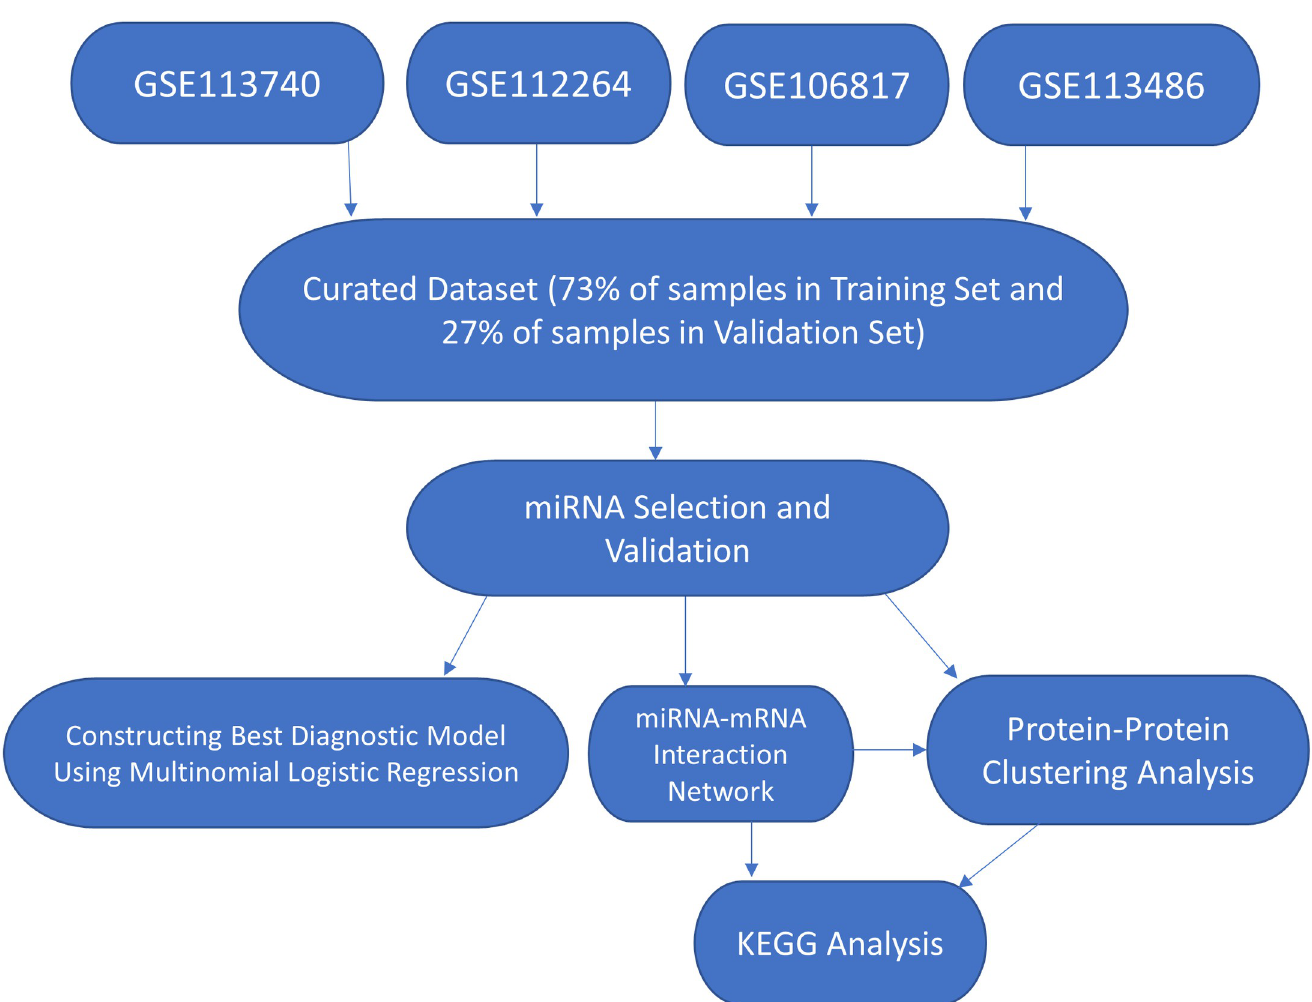
Fig 1. Analysis workflow of the study. The microarray data were manually curated from four studies (GSE113740, GSE112264, GSE106817, GSE113486) and combined for miRNA selection. The selected miRNAs were then used to classify and validate cancer subjects. miRNA-mRNA interaction network, protein-protein clustering analysis, and KEGG analysis were